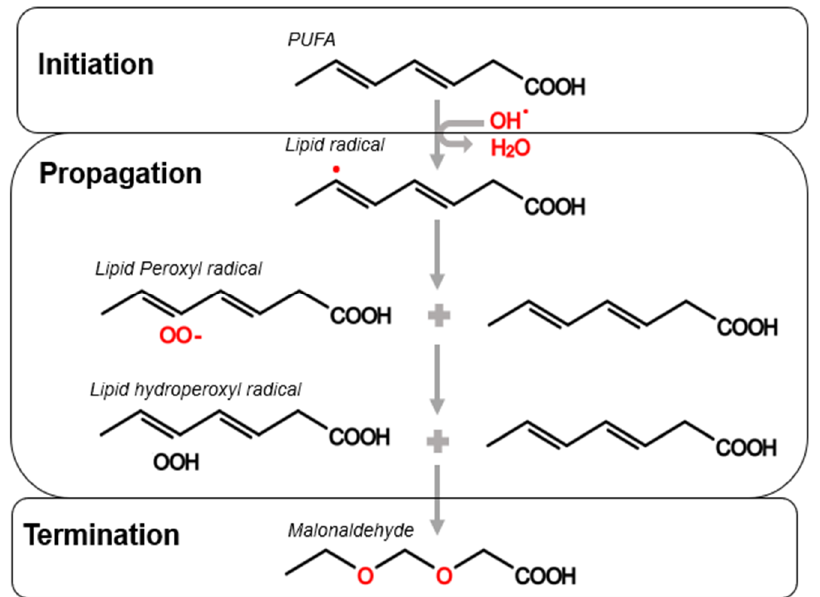
Figure 3. Summary of the three steps involved in lipid peroxidation: initiation, propagation, and termination. Adapted from [13,67,69]